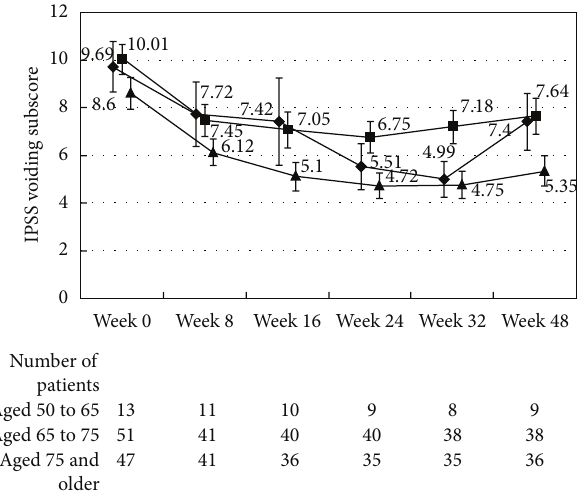
Figure 8: International Prostate Symptom Score voiding subscore by age. The scores in the patients aged from 50 to 65 ( ⧫ ), the patients aged from 65 to 75 ( ◼ ), and the patients aged 75 and older ( 󳵳 ) are shown. The values are LS mean ± SE. 𝑃 = 0.7578 (repeated